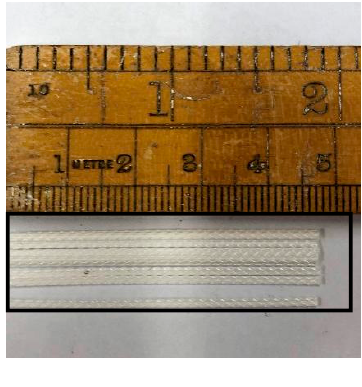
Figure 2. Duras S500 fibre. Table 1. Properties of Duras S500 fibre.